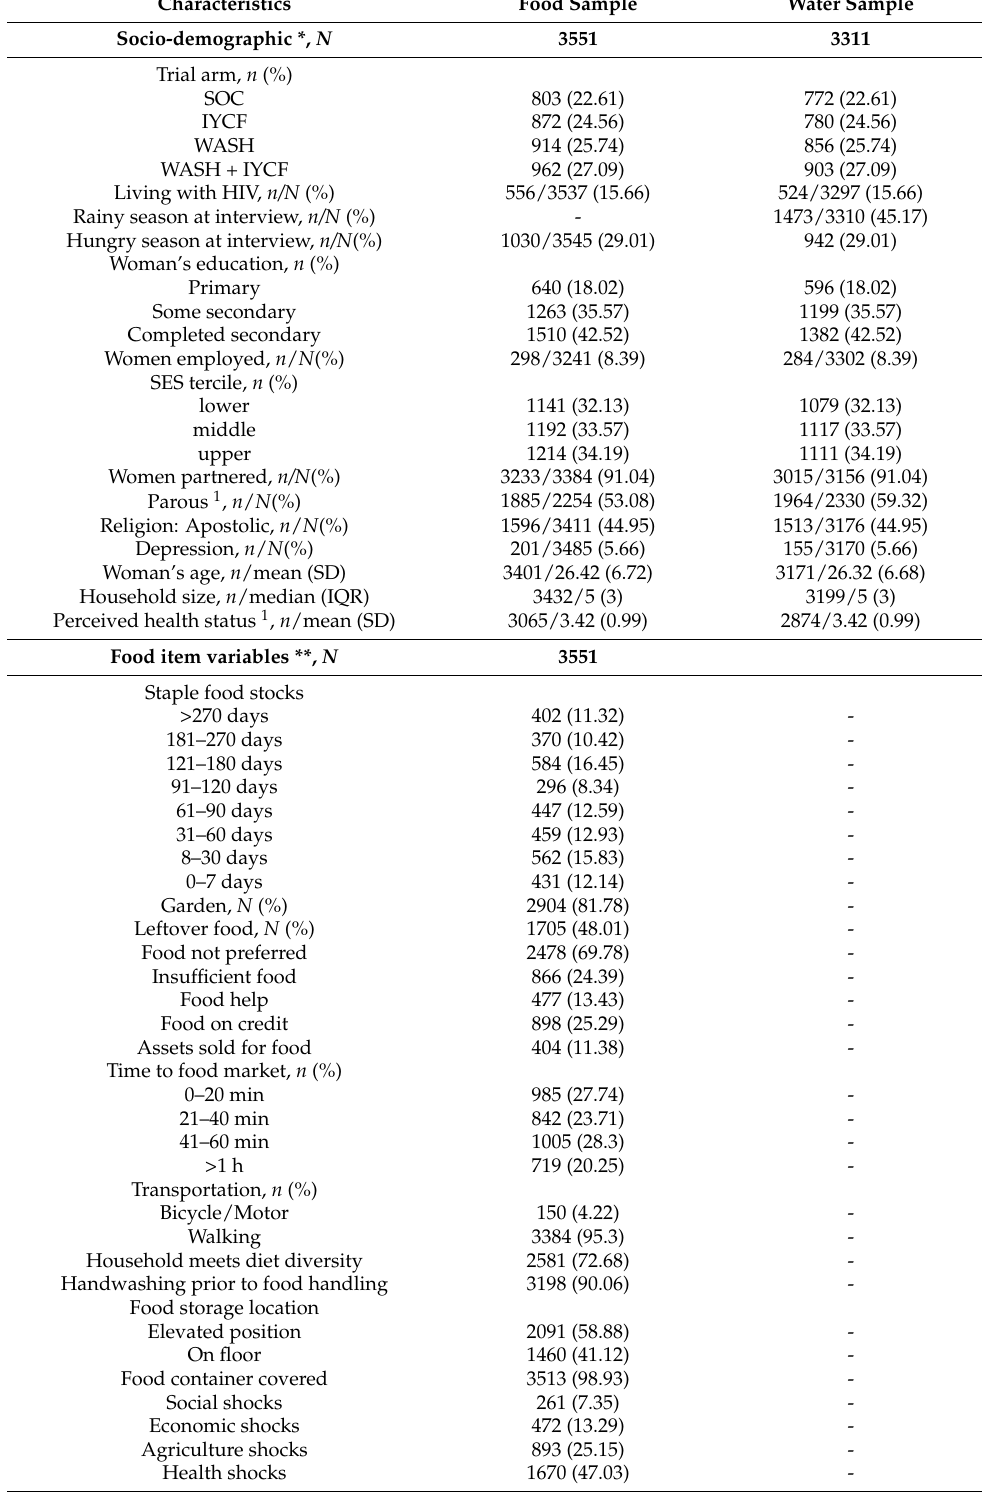
Table 3. Socio-demographic characteristics of households included in